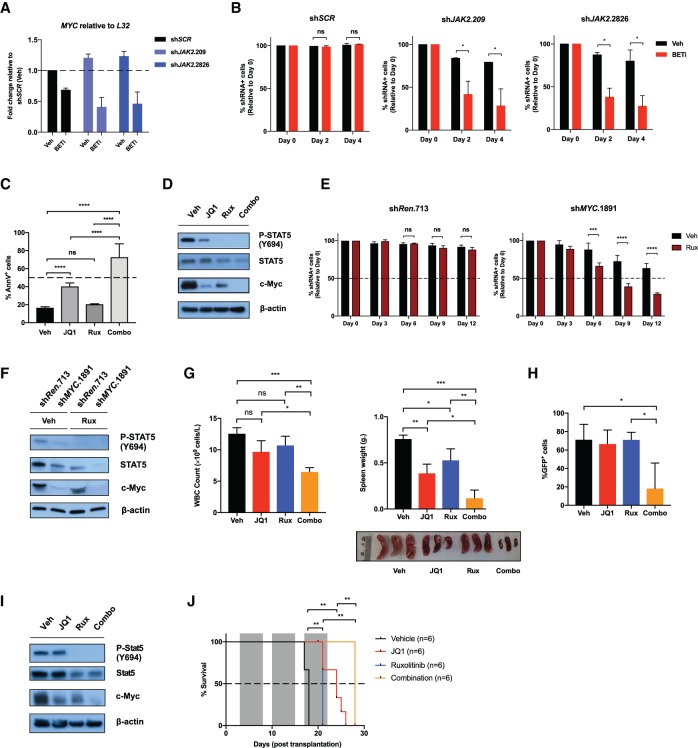
Combined targeting of JAK2 and c-Myc is effective against CRLF2/JAK2 mutant B-ALLs. (A) MHH-CALL4-pLMS-shSCR, MHH-CALL4-pLMS-shJAK2.209, and MHH-CALL4-pLMS-shJAK2.2826 cells were treated with vehicle (Veh; DMSO) or 500 nM iBET151 (BETi) for 24 h at day 12 after transduction, and mRNA levels for MYC were determined by qPCR. (B) Cells in A were analyzed for the percentage of shRNA-expressing cells (GFP+) by flow cytometry (days 0, 2, and 4 after drug treatment), and data were normalized to day 0. (C) MHH-CALL4 cells were exposed to vehicle (Veh; DMSO), 500 nM JQ1, 1000 nM ruxolitinib (Rux), or the combination (Combo) for 72 h, and the percentage of Annexin V-positive (AnnV+) cells was assessed. (D) Immunoblotting for the indicated targets was performed on lysates from MHH-CALL4 cells treated as in C for 24 h. (E) MHH-CALL4 cells were transduced with constitutive (pLMS-eBFP2) retroviral vectors harboring shMYC.1891 or shRenilla.713 (shRen.713). At day 5 after transduction, transduced and nontransduced populations were passaged in vitro for 12 d with vehicle (Veh; DMSO) or 1000 nM ruxolitinib (Rux). Drugs were replenished to the indicated concentrations, and the percentage of eBFP2+ cells was assessed by flow cytometry every 3 d. (F) Immunoblotting for the indicated targets was performed against MHH-CALL4-pLMS-shRenilla.713 (shRen.713) and MHH-CALL4-pLMS-shMYC.1891 (shMYC.1891) cells treated with vehicle (Veh; DMSO) or 1000 nM ruxolitinib (Rux) for 24 h. (G, H) Cohorts of C57BL/6 wild-type CD45.1+ mice were transplanted with Eµ-Crlf2/Jak2R683G B-ALL. After 12 d, mice were treated with vehicle (Veh), 50 mg/kg JQ1 once per day, 90 mg/kg ruxolitinib (Rux) twice per day, or the combination (Combo; JQ1 and ruxolitinib). Spleen weight, total peripheral WBC count, and percentage of GFP+ cells in the spleens of individual mice in each treatment group were assessed after 3 d of therapy. A photograph of spleens from mice in each treatment arm is shown. n = 3 per group. The ruler scale is in centimeters. (I) Immunoblotting for the indicated targets was performed on lysates from Eμ-Crlf2/Jak2R683G B-ALLs treated with vehicle (Veh; DMSO), 500 nM JQ1, 1000 nM ruxolitinib (Rux), or the combination ex vivo for 8 h. (J) Kaplan-Meier survival curve of recipient mice transplanted with Eµ-Crlf2/Jak2R683G B-ALLs treated as in G from 3 d after transplantation (the gray area indicates the period of drug treatment). β-Actin served as a loading control for all immunoblots. Error bars in A–C represent SEM (n = 2); error bars in E represent SEM (n = 3). (*) P < 0.05; (**) P < 0.01; (***) P < 0.001; (****) P < 0.0001; (ns) nonsignificant.